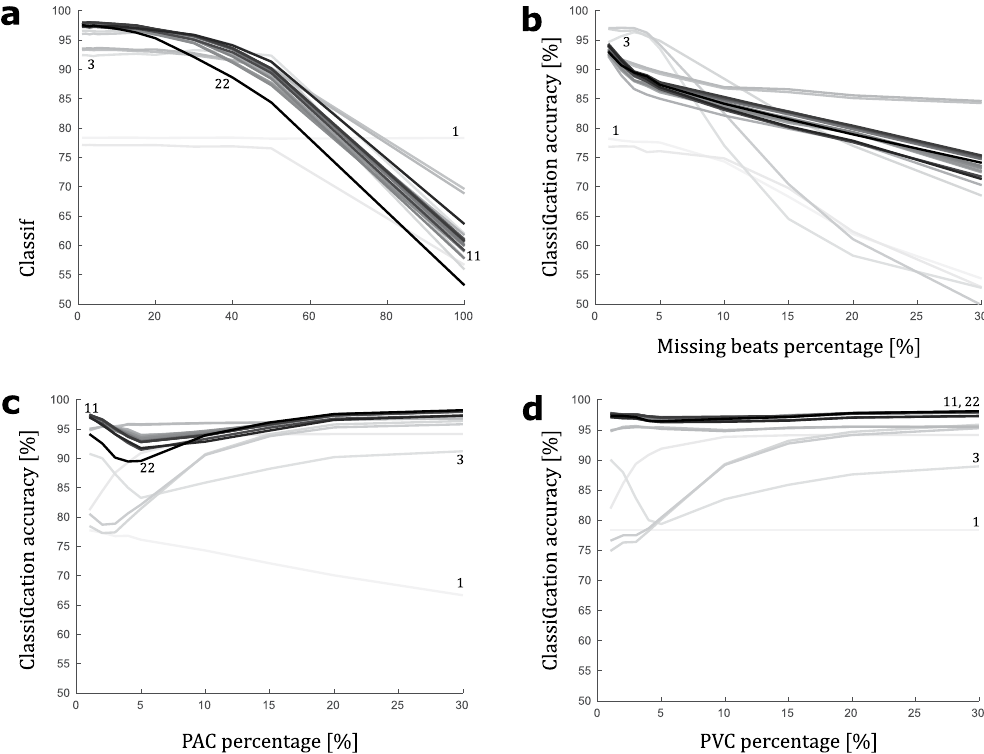
Figure 7. Robustness of the γ -analysis to noisy data. Classification accuracy of multivariate logistic regression in discriminating the Normal Sinus Rhythm (NSR, N = 4,500) and Atrial Fibrillation (AF, N = 2,900) states for 1-min RR interval time series, combining 1 to 22 input variables according to the 1 to 22 n-tuples with the 22 ( ) 122 possible combinations in the preliminary γ -analysis selection highest γ -value identified among the ∑ = k k plotted against ( a ) timing uncertainty applied to each R peak detection, ( b ) missing beats percentage applied to each RR interval time series used, ( c ) premature atrial contractions (PAC) percentage applied to each RR interval time series used, ( d ) premature ventricular contractions (PVC) percentage applied to each RR interval time series used. In ( a – d ), all models are colour-coded from light grey to black according to the number of included variables (from 1 to 22). Extrema are labelled, 1-variable and 22-variable models, as well as the best model (3 variables) defined by the γ -analysis when learning was performed on a noiseless dataset and the best model (11 variables) γ -analysis when learning was performed on pooled noisy